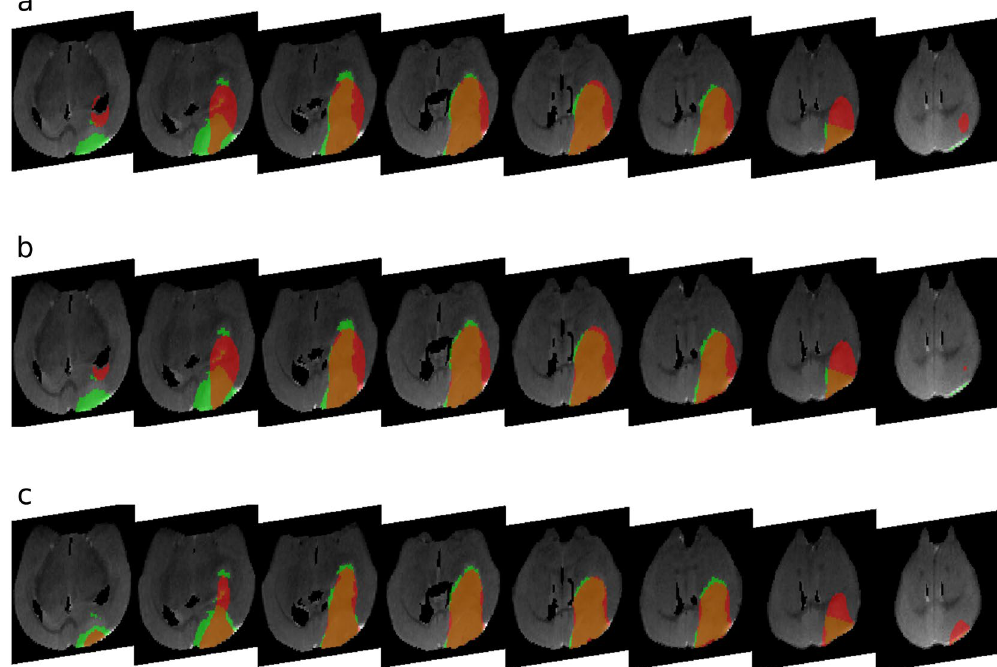
Figure 2. Representative simulation results for Mouse 1 at day 25 following implantation under ( a ) Hypothesis 1, ( b ) Hypothesis 2, and ( c ) Hypothesis 3. The simulated enhancing tumor volume is shown in red, and the segmented regions of enhancement in the laboratory tumor in green for eight different slices of the MR